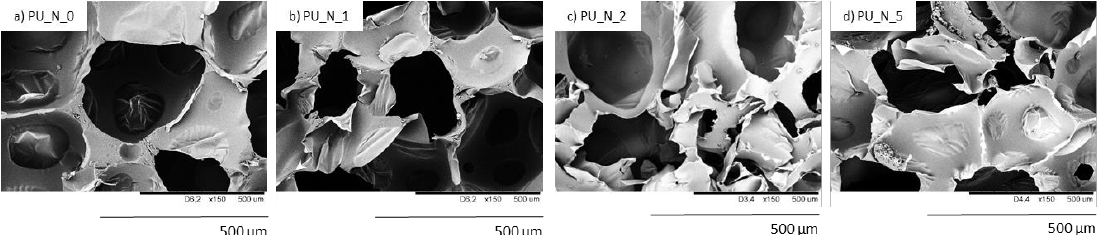
Figure 6. The cellular structure of ( a ) PU_N_0, ( b ) PU_N_1, ( c ) PU_N_2 and ( d ) PU_N_5 observed at a magnification of ×50. Adapted from Ref. [10].